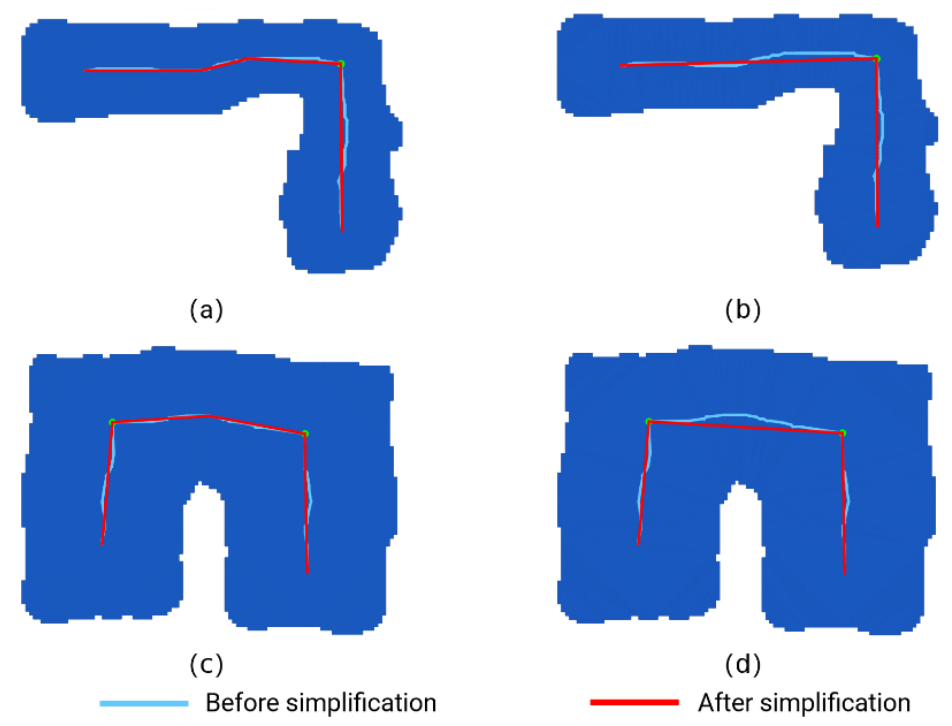
Figure 15. Skeleton line segment DP simplification results with different threshod; ( a ) L-shaped building with a threshold of 1 m; ( b ) L-shaped building with a threshold of 3 m; ( c ) C-shaped building with a threshold of 1 m; ( d ) C-shaped building with a threshold of 3